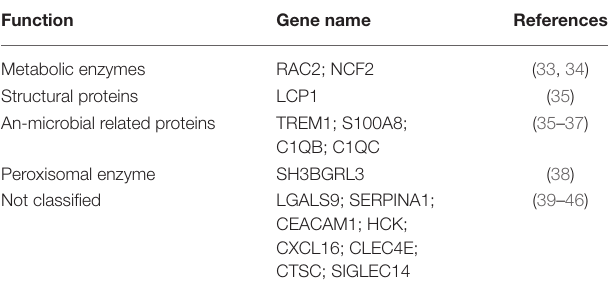
TABLE 3 | Annotation of Nets associated genes.